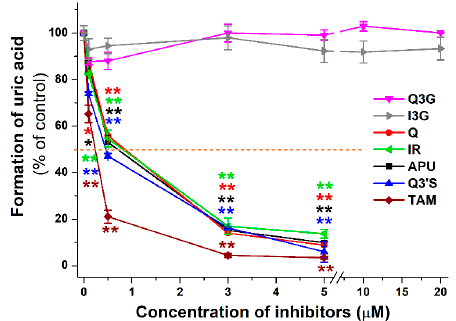
Figure 6. Inhibitory effects of Q and its conjugated metabolites on XO-catalyzed oxidation of xanthine (5 μ M) after 8 min incubations, in the presence of increasing concentrations of allopurinol (APU), quercetin (Q), isorhamnetin (IR), tamarixetin (TAM), quercetin-3 ′ -sulfate (Q3 ′ S), quercetin-3- glucuronide (Q3G), and isorhamnetin-3-glucuronide (I3G). The 50% inhibition of uric acid formation (IC 50 ) is marked with dashed line (* p < 0.05, ** p < 0.01).